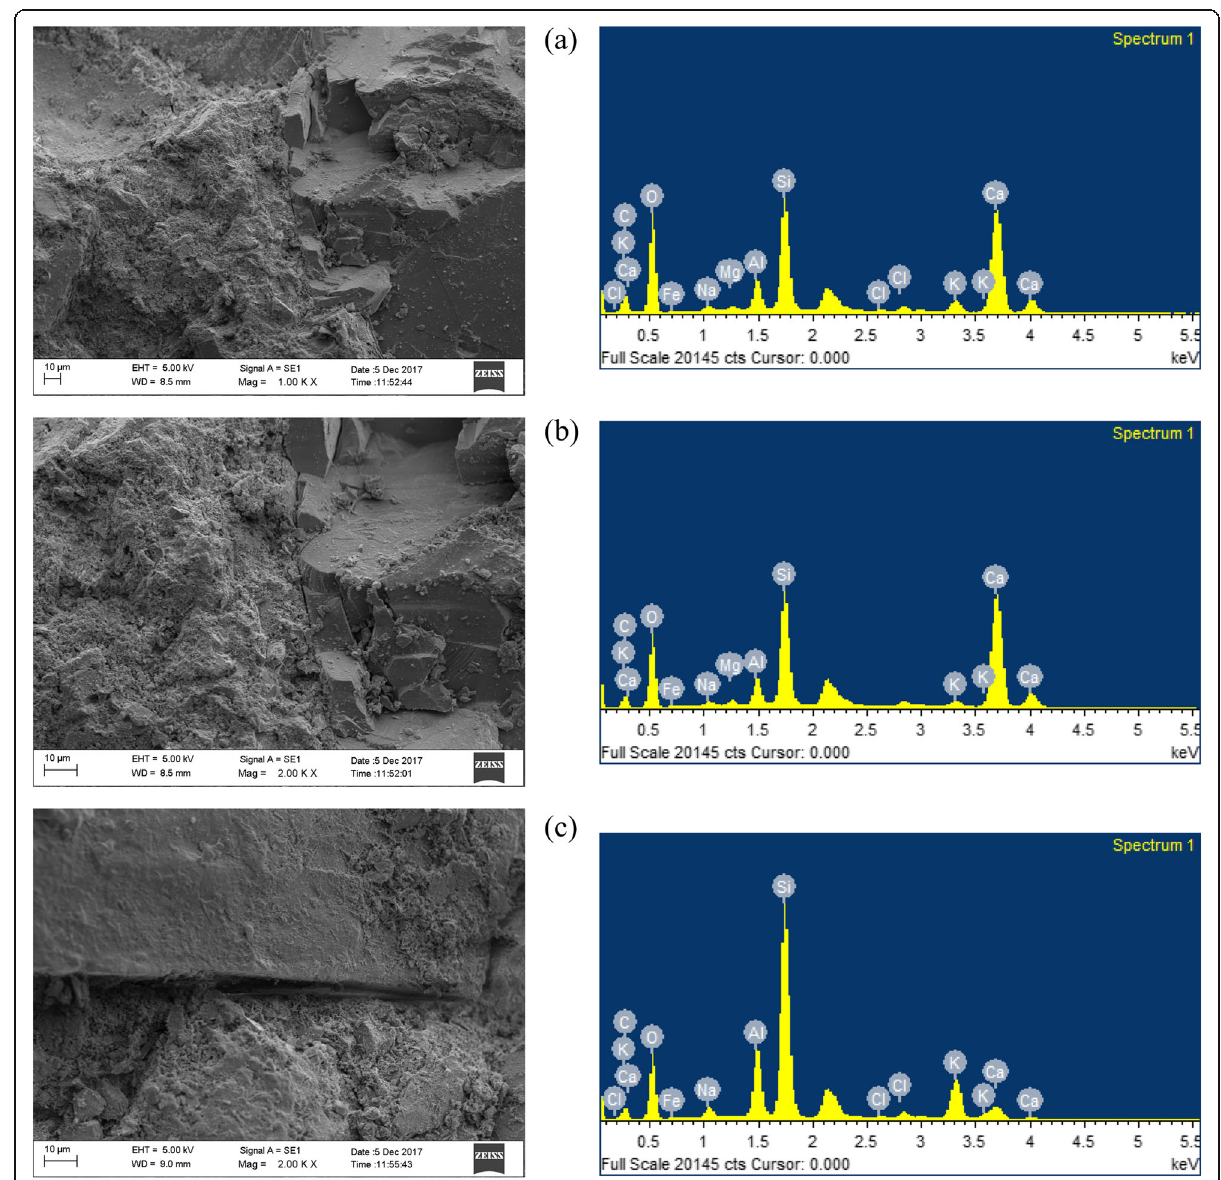
Fig. 6 SEM image and EDX analysis of specimens ( a ) Trial 1 ( b ) Trial 5 and ( c ) Trial